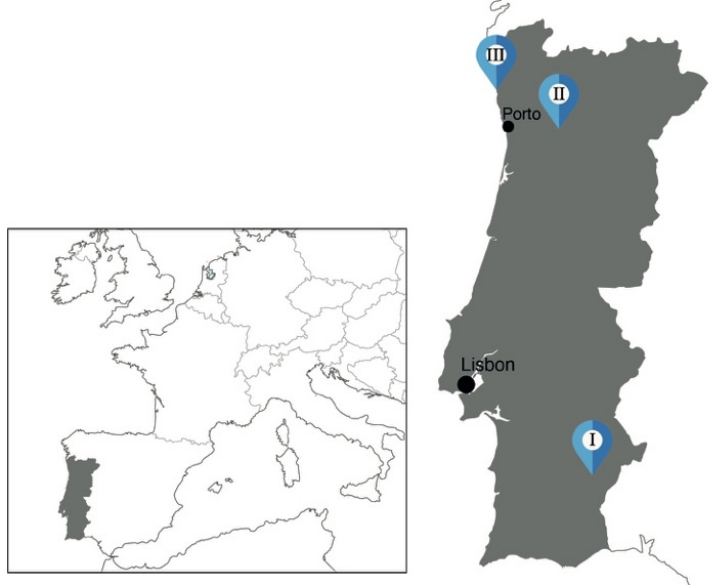
Figure 2. Giant reed harvest regions: Serpa (Region I), Santa Cruz do Douro (Region II) and Apúlia (Region III). Table 1. Climate data for the giant reed harvesting sites